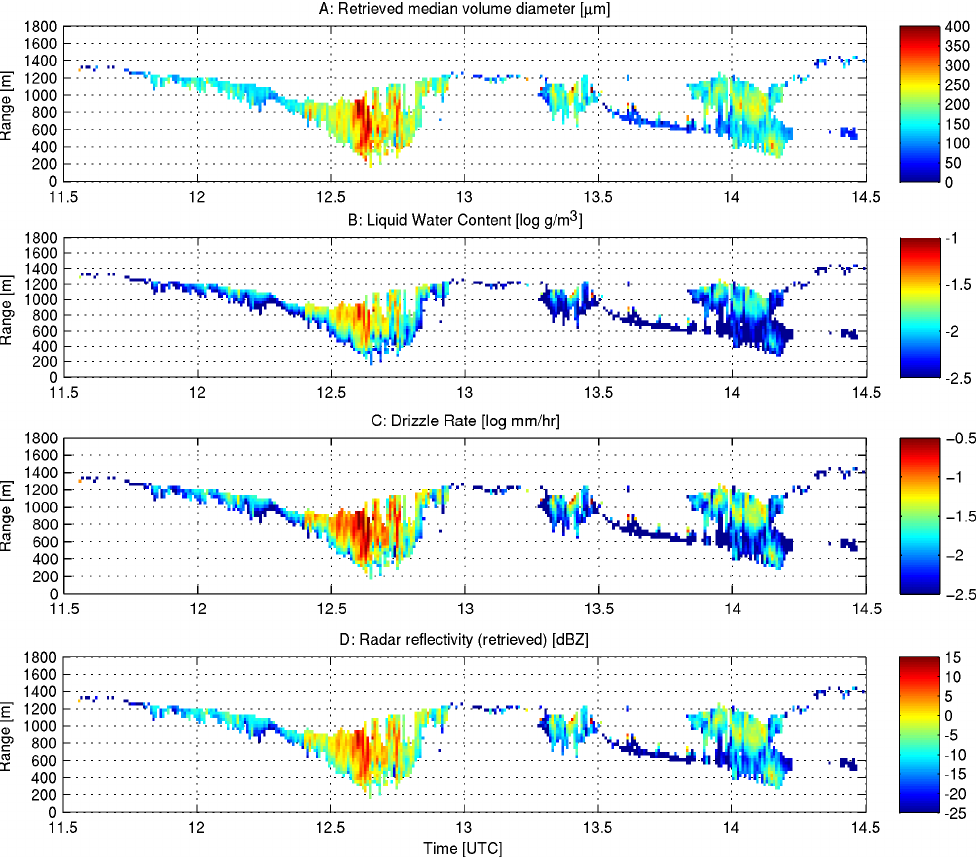
Fig. 7. Retrieved median volume drop diameter (A) , liquid water content (B) , drizzle rate (C) and radar reflectivity (D) on 5 November 2007, assuming µ = 2 .